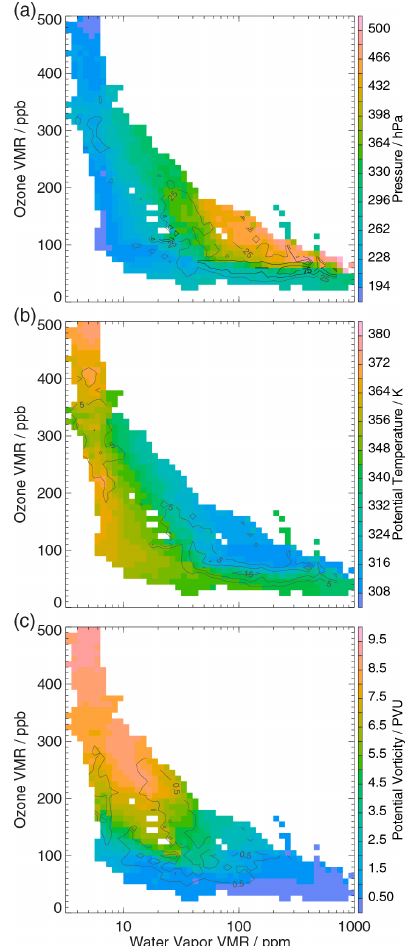
Figure 4. Tracer–tracer (T–T) correlations of O 3 and H 2 O for the collocated DIAL data on 1 October 2017. (a) All collocated obser- vations, (b) number of data points and (c) air mass classification for bins in T–T space (bin sizes of 10ppb for VMR O 3 and 0.05ppm of log 10 (VMR H 2 O)).